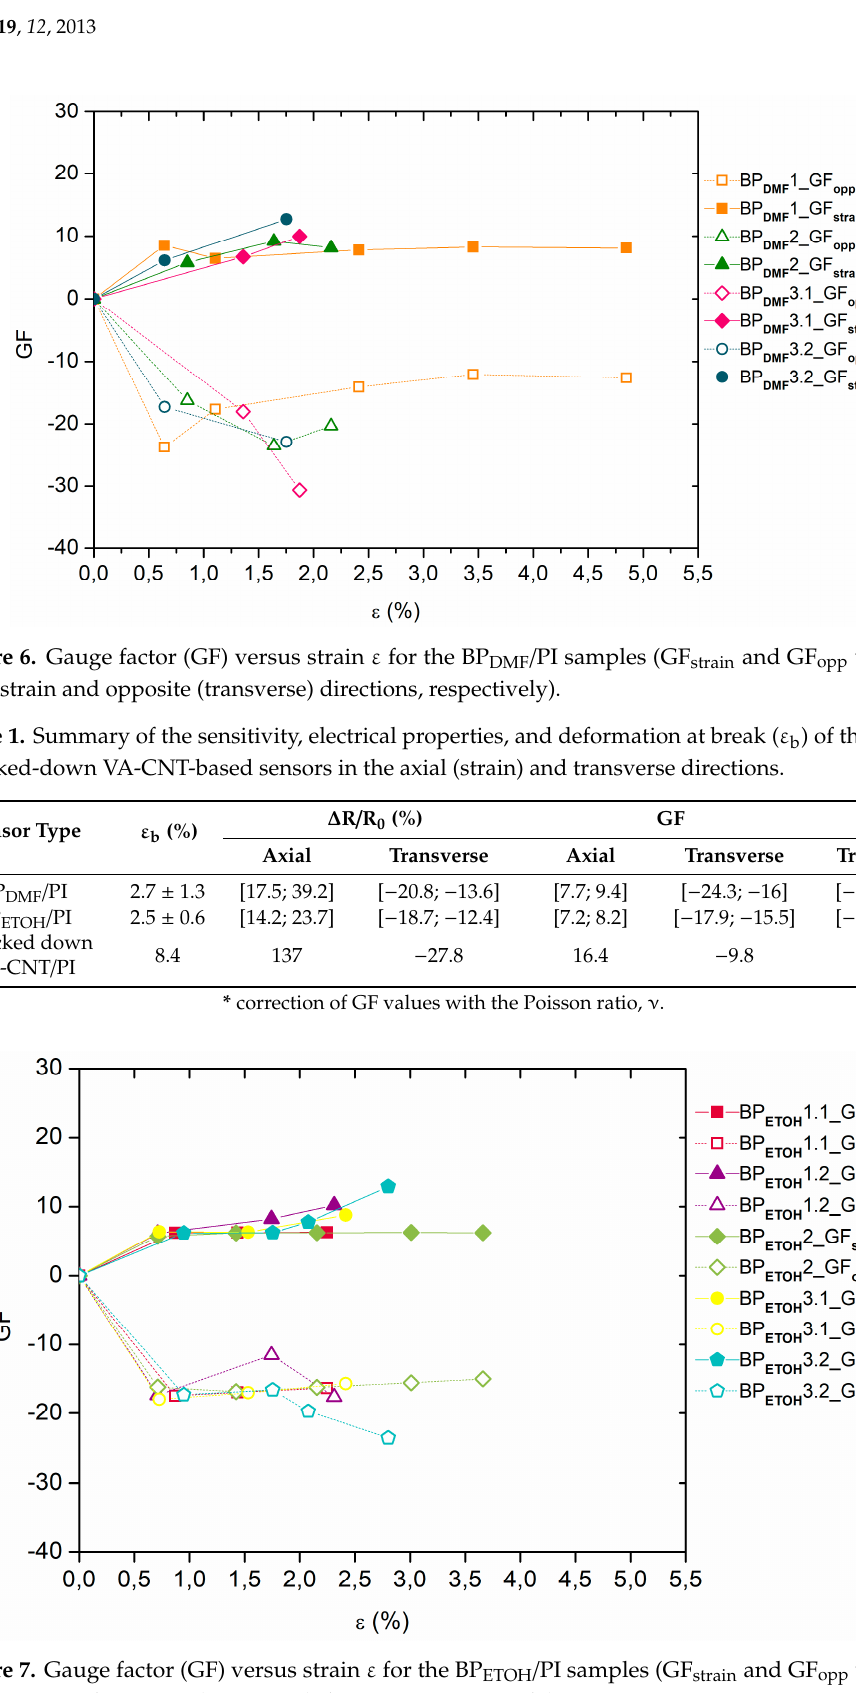
Figure 7. Gauge factor (GF) versus strain ε for the BP ETOH / PI samples (GF strain and GF opp values in axial strain and opposite (transverse) directions, respectively).